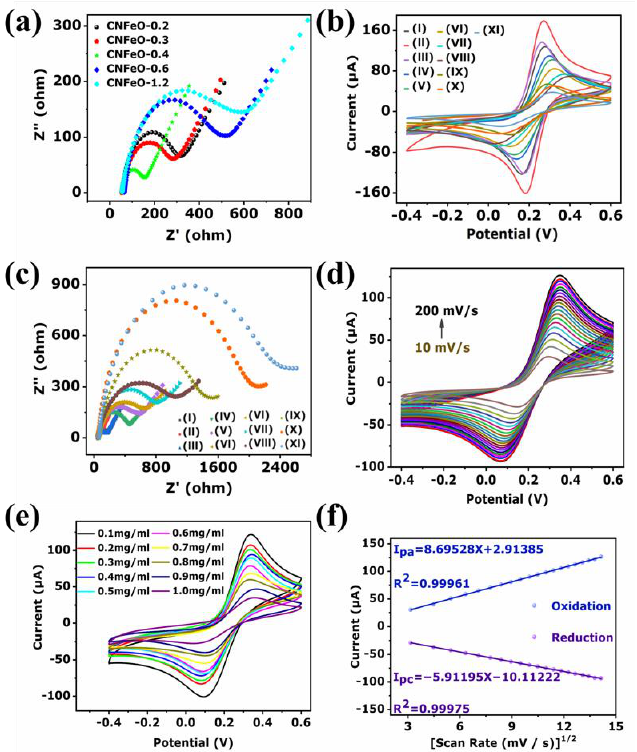
Figure 4. ( a ) EIS of different proportions of g-C 3 N 4 @Fe 3 O 4 , ( b ) CV of electrodes under different modified conditions, ( c ) EIS of electrodes under different modified conditions, ( d ) CV under different sweep speeds of 10 – 200 mV/s, ( e ) CV for different concentrations of β -Casein (0.1 mg/mL to 1.0 mg/mL), and ( f ) Fitting equations and R 2 for CV.